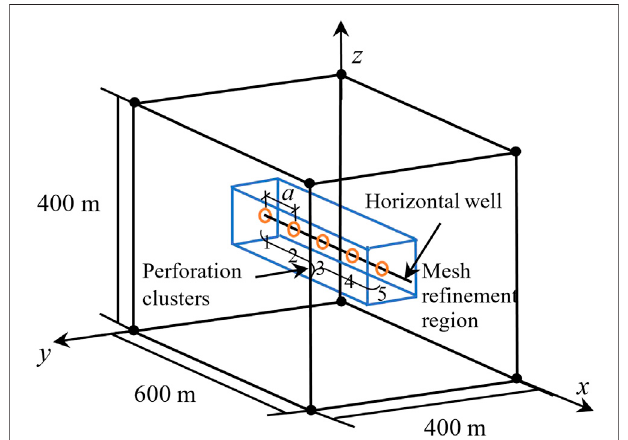
FIGURE 2 | Initial geometric engineering-scale 3D model of multistage hydrofracturing of horizontal well with fi ve perforation clusters.